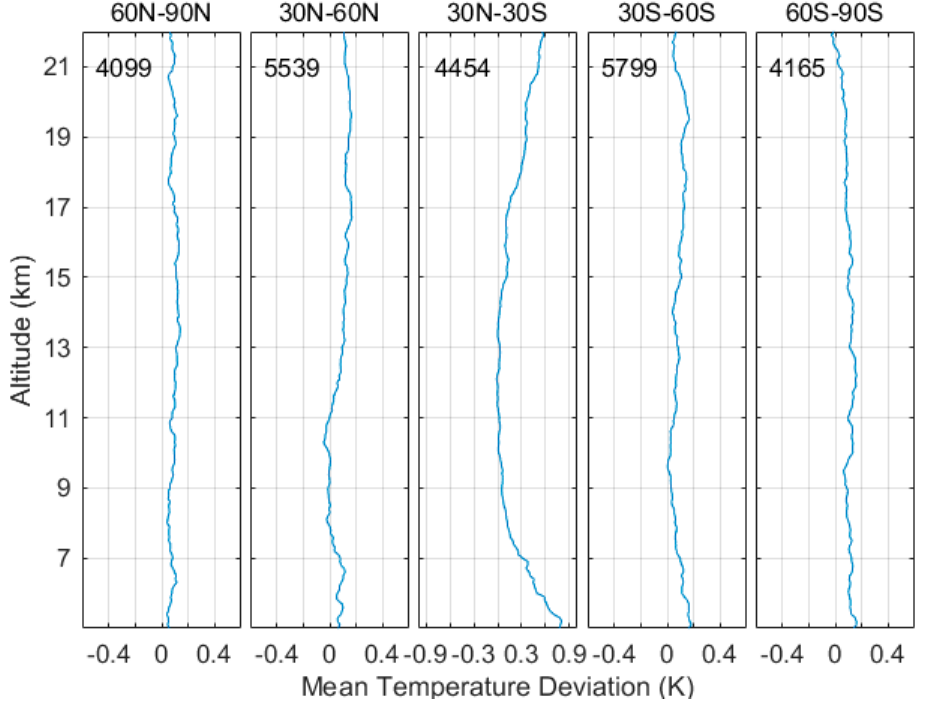
Figure 3. Mean temperature deviation between FengYun 3 series C satellite global navigation satellite system occultation sounder (FY-3C GNOS) and Constellation Observing System for Meteorology, Ionosphere and Climate (COSMIC) in different latitude bands, and the number noted at the top-left corner of each panel is the number of collocated pairs.